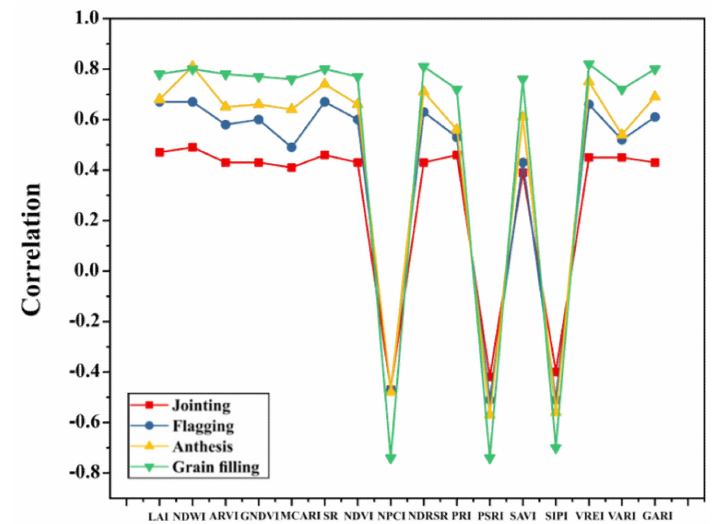
Figure 4. Correlation between grain yield and indices of each growth stage.